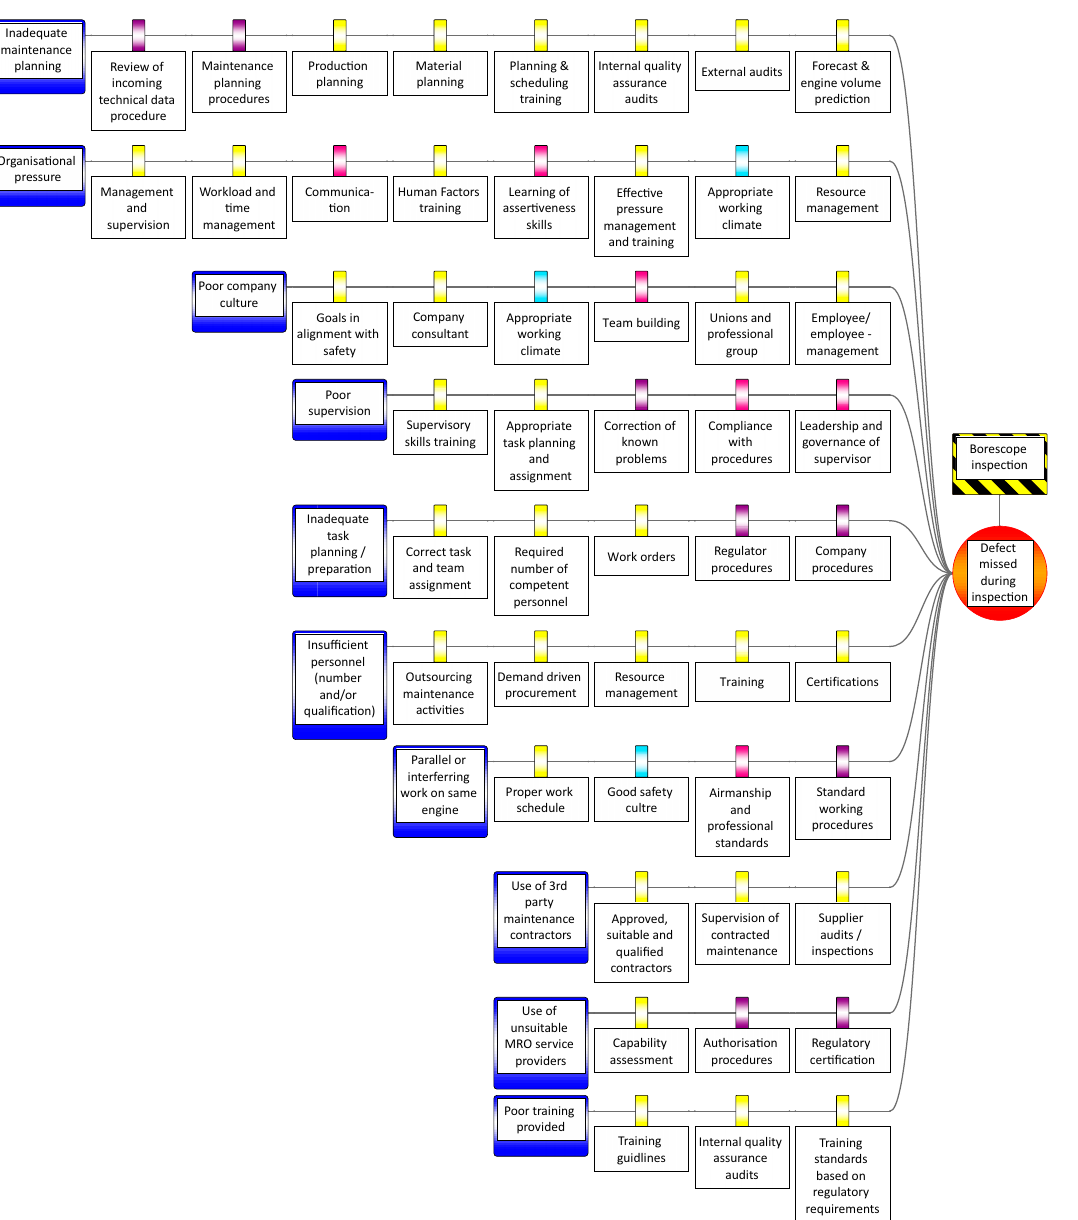
Figure A7. Management-related threat paths with barriers.